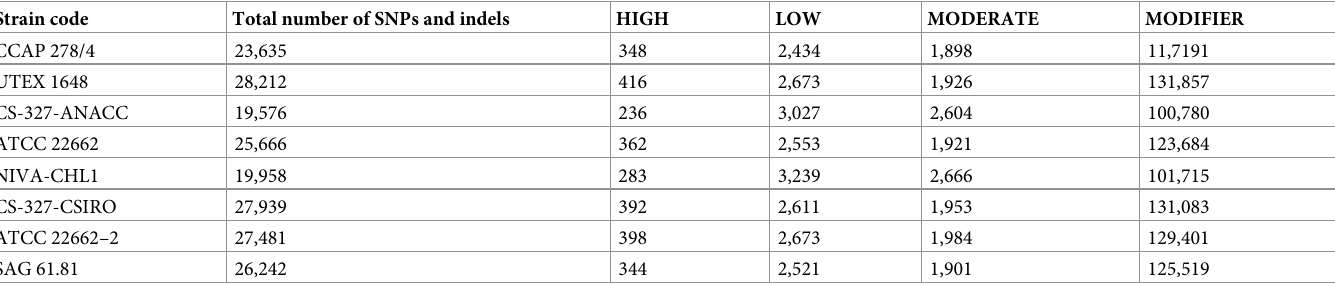
Table 3. Summary of categorization of single-nucleotide polymorphisms (SNPs) and indels in comparison with the genome of NIES-35. Strain